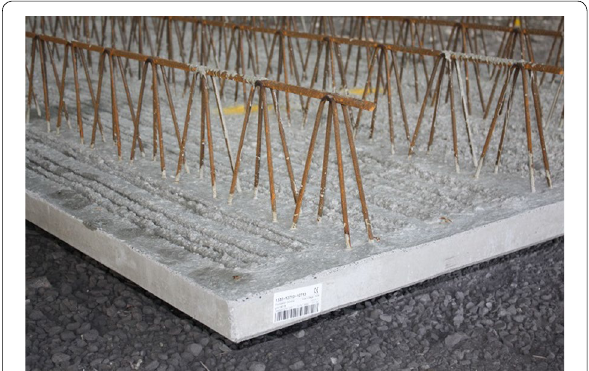
Fig. 3 Precast concrete lattice girder